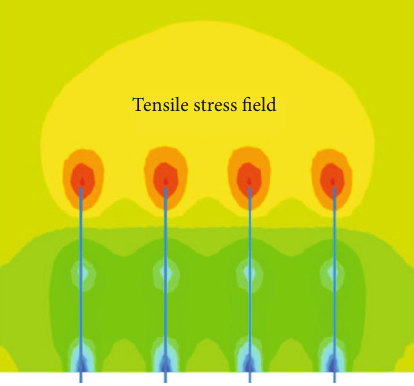
Figure 10: Bolt tensile stress fi eld.